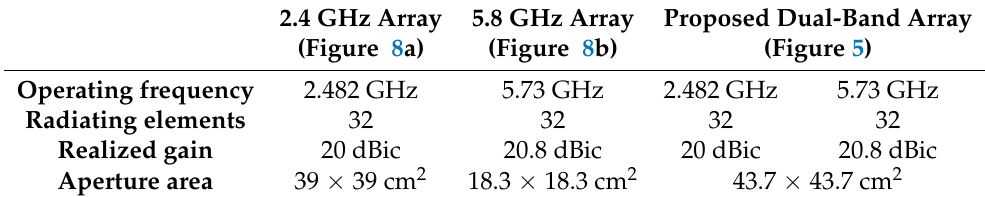
Table 1. Comparison according to the implementation method of the dual-band array